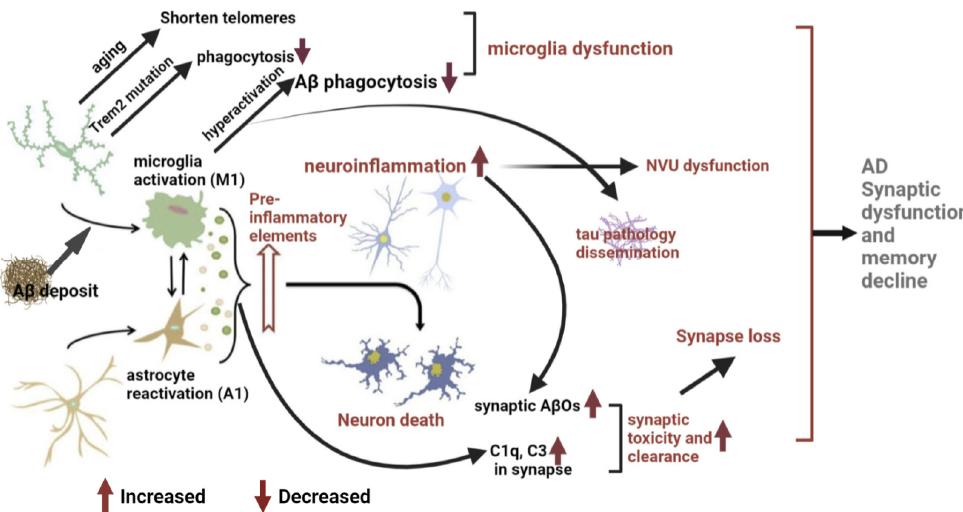
Figure 3. Microglial mechanism of memory impairment in AD. Chronic and pathological activation of microglia during AD progress causes neuro-inflammation, microglia dysfunction, synapse loss and synaptic toxicity, and microglia-driven tau pathology, which work together to contribute to AD synaptic dysfunction and memory impairment. Abbreviations: A β , Amyloid β ; Trem2, triggering receptor expressed on myeloid cells 2; A β Os, soluble A β oligomers; C1q and C3, the complement component 1q and 3; NVU, neurovascular unit.